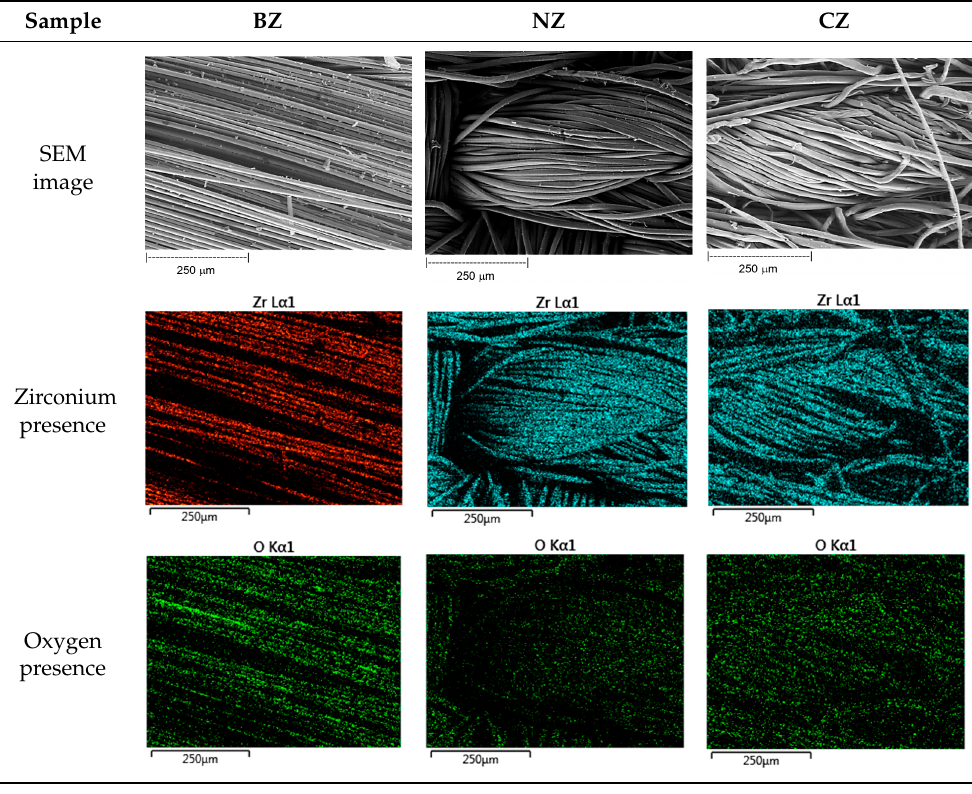
Table 6. Analysis of main chemical constituents present in the zirconia coating.